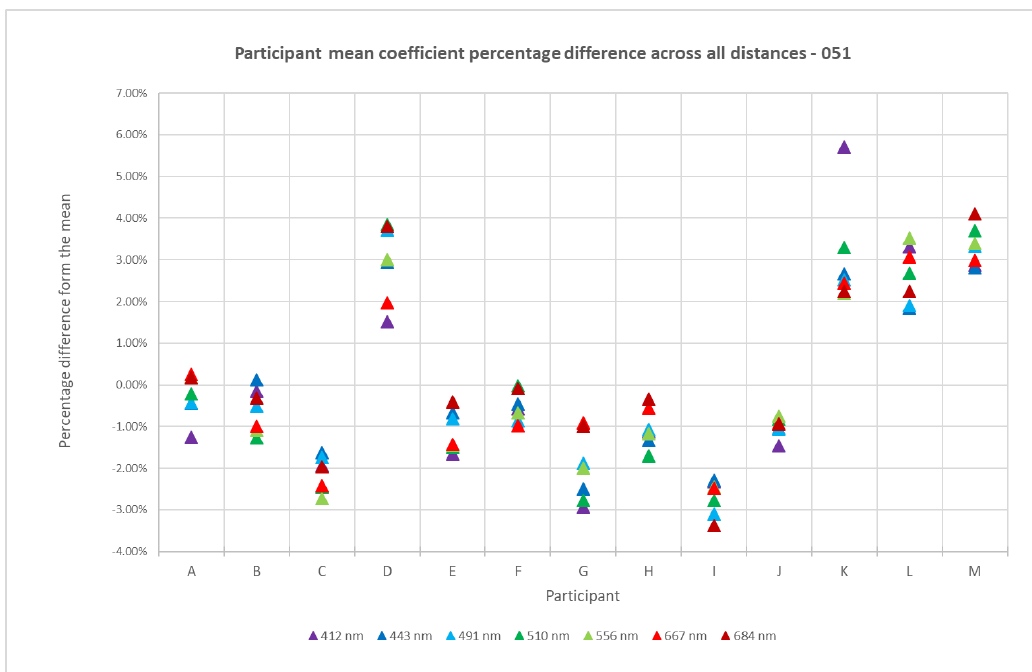
Figure 5. Results of the radiance comparison for radiometer 051. Radiance calibration coefficient compared to mean calibration coefficient for each participant/set-up at each wavelength.